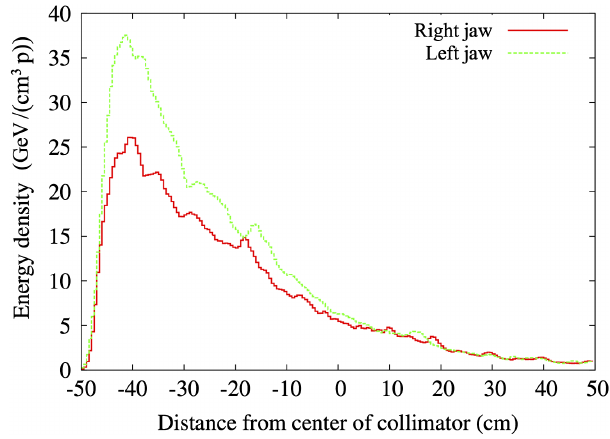
FIG. 9. Maximum energy density per interacting proton over the collimator jaw length, sampled from the losses by all simulated bunches, obtained by FLUKA simulations.